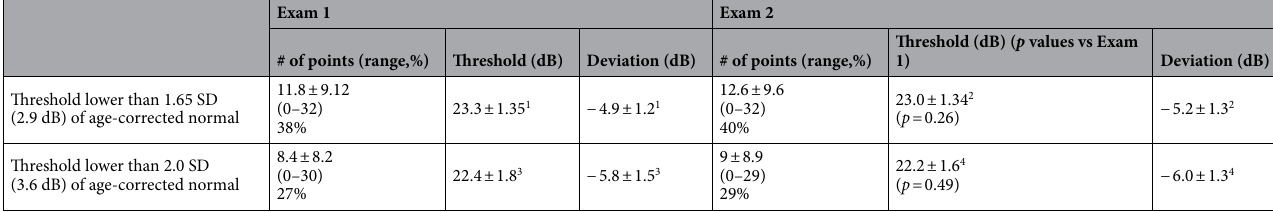
Table 1. Number of abnormal points in 2 successive mesopic Maia exams in 25 iAMD eyes using 2 criteria for abnormality, and the average threshold and deviation of these points. 1 There was one eye with no abnormal points, so it was not included in this analysis. 2 –4 There were 2 eyes with no abnormal points, so they were not included in this analysis.